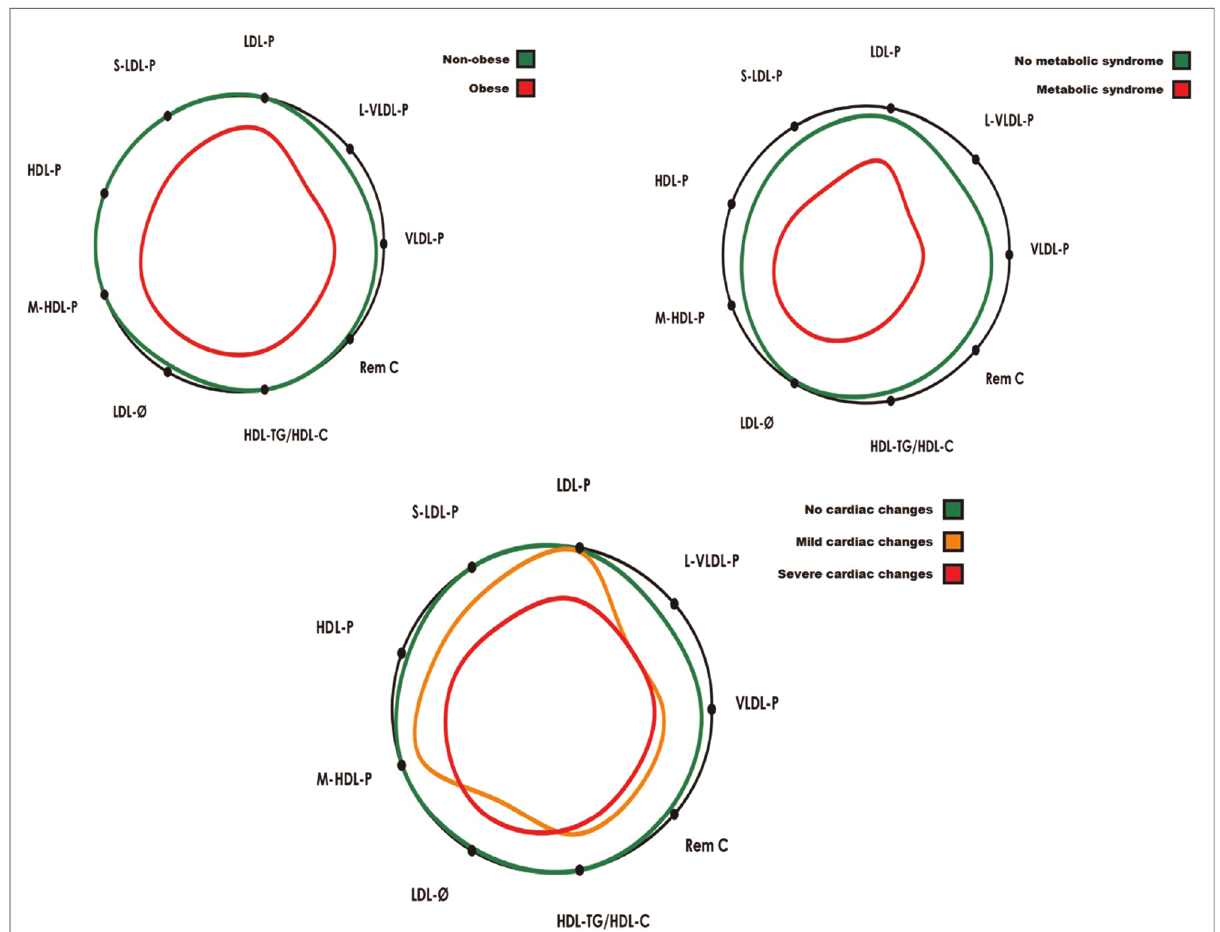
FIGURE 1 The lipid contour is a graphical model to facilitate the lipoprotein pro fi le interpretation and its association with cardiovascular risk. The colored silhouettes represent the patient groups ’ values with respect to the values of an apparently healthy population (black circle) (30). The study group ’ s contour delimits a smaller central area when the variables have values associated with an increased risk of developing CVD (i.e., values higher than the reference population ’ s mean for L-VLDL-P, VLDL-P, Rem-C, S-LDL-P, LDL-P, HDL-TG/HDL-C variables; or lower than reference population ’ s mean for LDL-Ø, HDL-P and M-HDL-P variables). Colored silhouettes are represented in percentage of increase or reduction regarding data in Tables 1 – 3 . Bottom of the fi gure: VLDL-P, total VLDL particles; L-VLDL-P, large VLDL particles; LDL-P, total LDL particles; S- LDL-P, small LDL particles; HDL-P, total HDL particles; M-HDL-P, medium HDL particles; LDL-Ø, LDL particles diameter; HDL-TG/HDL-C, triglyceride enriched HDL; Rem C, remnant